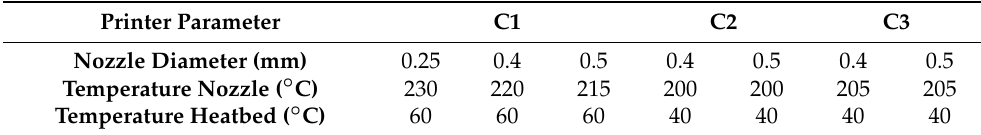
Table 4. Printing parameters for the different compounds.